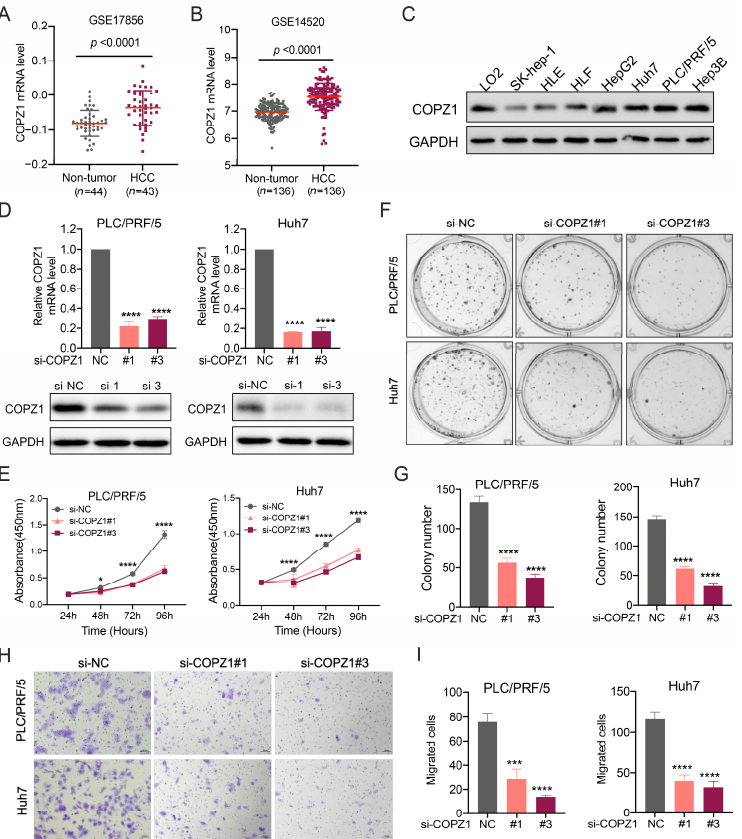
Figure 10. High COPZ1 levels contribute to the proliferation and migration of HCC. ( A , B ) The mRNA level of COPZ1 was higher in HCC tissues than the non-tumor tissues in GSE17856 and GSE14520 datasets. ( C ) The protein expression profile of COPZ1 in a panel of HCC cell lines and normal human liver cells. ( D ) Evaluation of the knockdown effect of siRNA targeted for COPZ1 in PLC/PRF/5 and Huh7 cells. ( E ) COPZ1 silence suppresses the cell viability of PLC/PRF/5 and Huh7 cells. ( F , G ) The representative images and statistical analysis of colony formation in PLC/PRF/5 and Huh7 cells treated with siRNA targeted for COPZ1 or negative control. ( H , I ) The representative images and statistical analysis of the migrated cells in the utter chamber in migration assay in PLC/PRF/5 and Huh7 cells treated with siRNA targeted for COPZ1 or negative control. The data are presented as the mean ± SDs. * p < 0.05, *** p < 0.001, **** p < 0.0001 (Student’s t